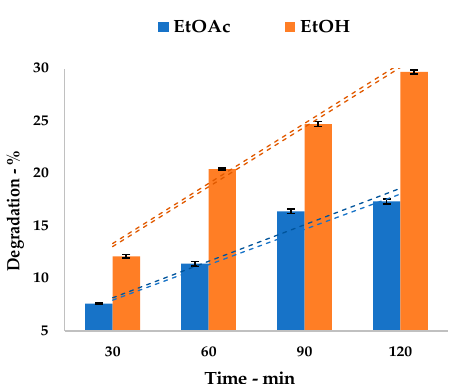
Figure 4. Curcumin standard degradation trend; dashed lines represent upper and lower SD envelopes.